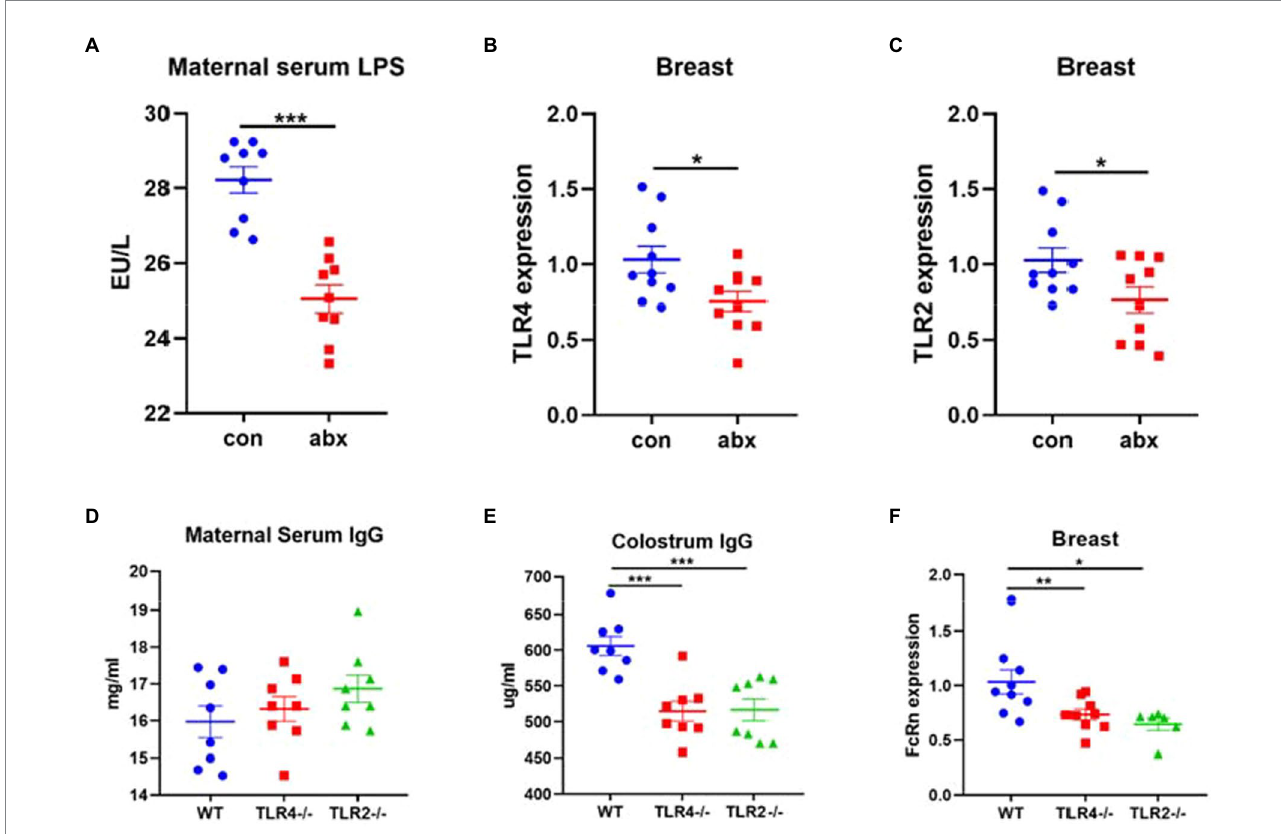
FIGURE 5 Antibiotic treatment affects the transmission of maternal antibody IgG through TLR2/4 receptor. (A) Maternal serum LPS. (B,C) TLR4 and TLR2 mRNA expression in breast. (D-F) Maternal serum IgG, colostrum IgG concentration and FcRn mRNA expression in breast of wild-type mice and TLR4 and TLR2 gene knockout